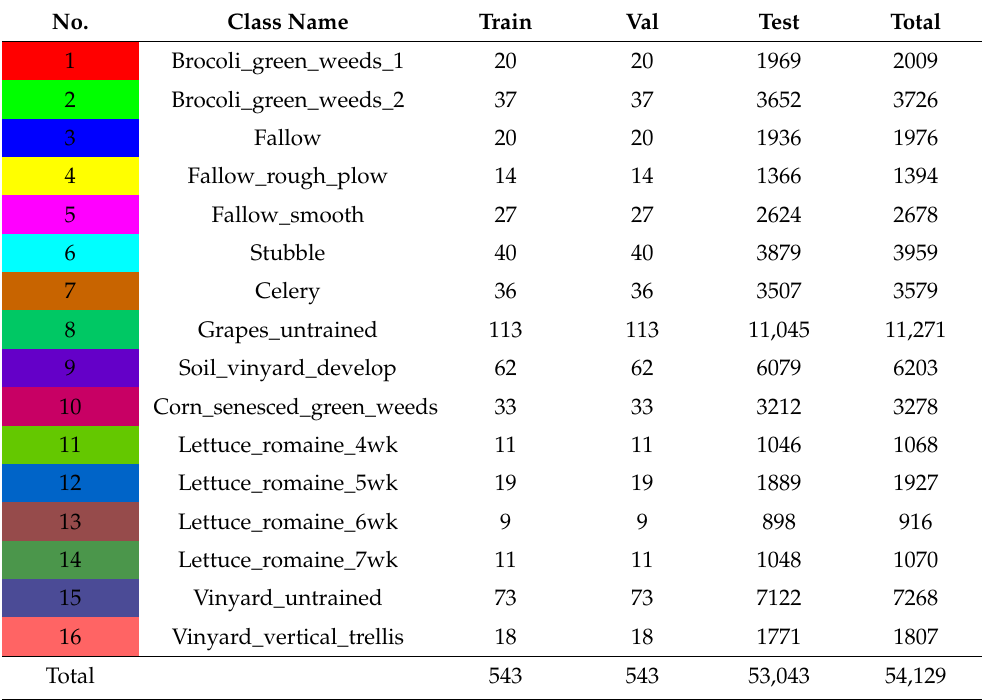
Table 3. Training validation and testing sample numbers in